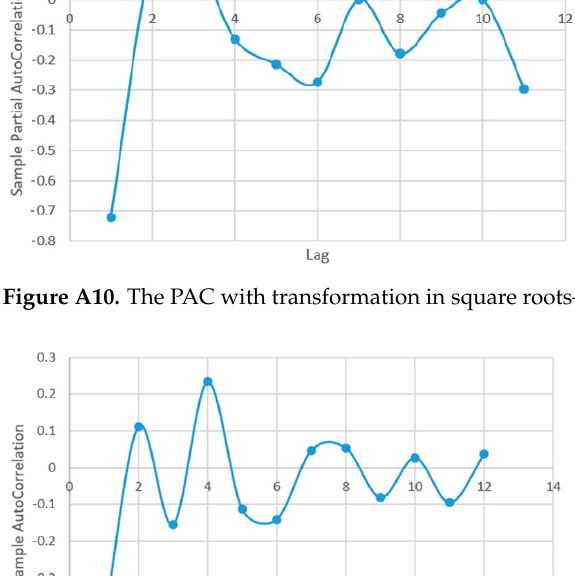
38 of 50 Figure A7. The AC with transformation in square roots—AR series. Figure A8. The PAC with transformation in square roots—AR series.